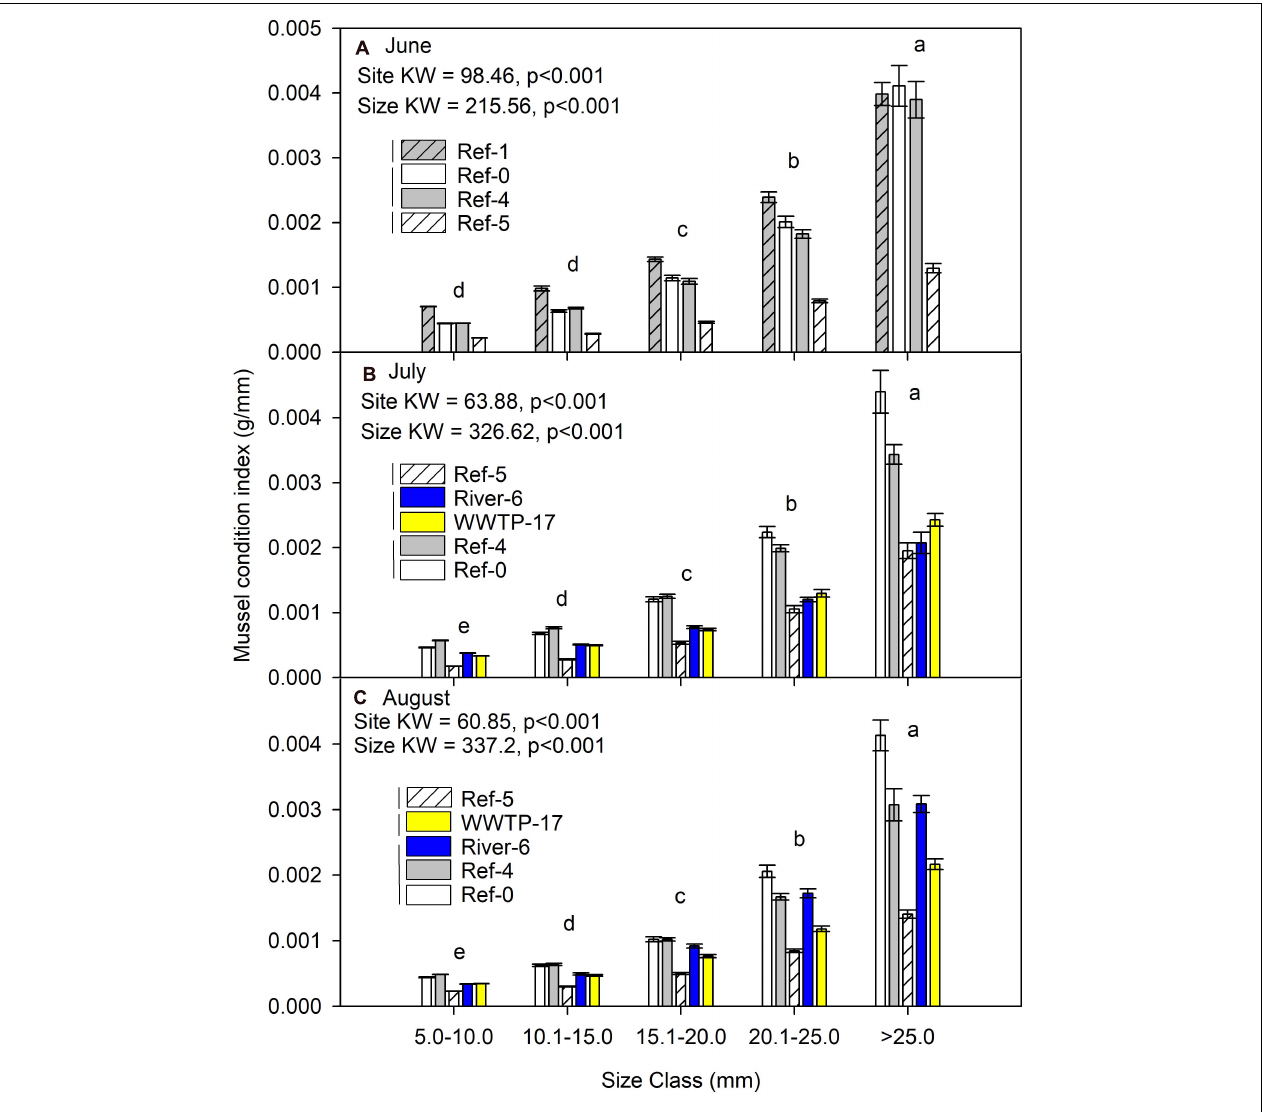
FIGURE 4 | Mean ( ± SE) condition index (dry mass/length) for in dreissenid mussels from Milwaukee Harbor in (A) June, (B) July, and (C) August 2018. K–W test results are shown in each panel, where df for size class = 4 in all panels, and df for site = 3 in panel (A) and df = 4 in panels (B,C) . In each panel, means with the same lowercase letter are not significantly different among sizes using post hoc comparisons ( p ≤ 0.05). Overlapping vertical lines next to the site legend are not significantly different after post hoc comparisons ( p ≤ 0.05). Ref, reference; WWTP, wastewater treatment